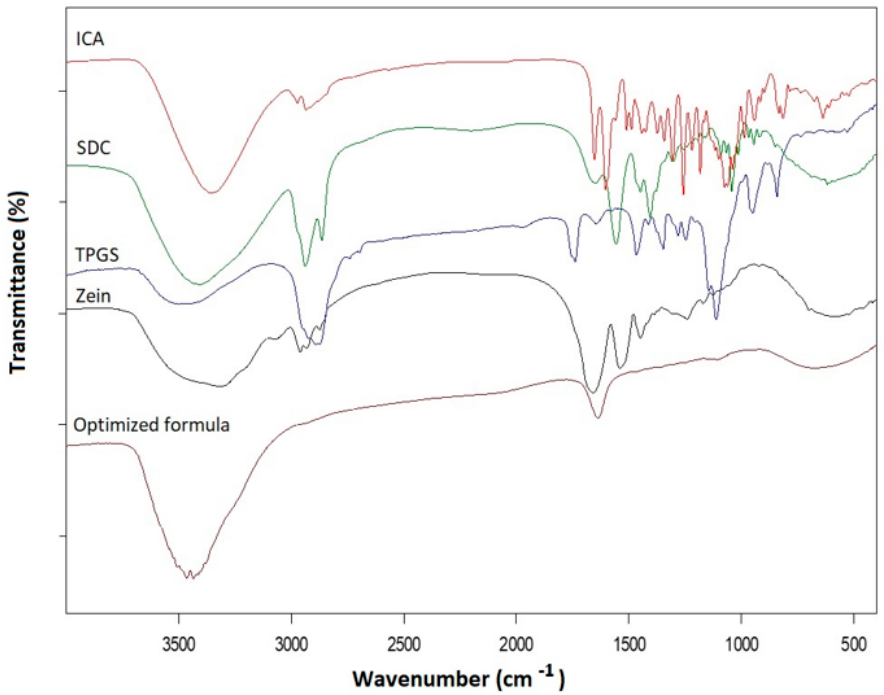
Figure 6. FTIR spectra of the optimized ICA-tocozeinolate nanosphere formula, and single formula components: ICA, SDC, TPGS, and zein.